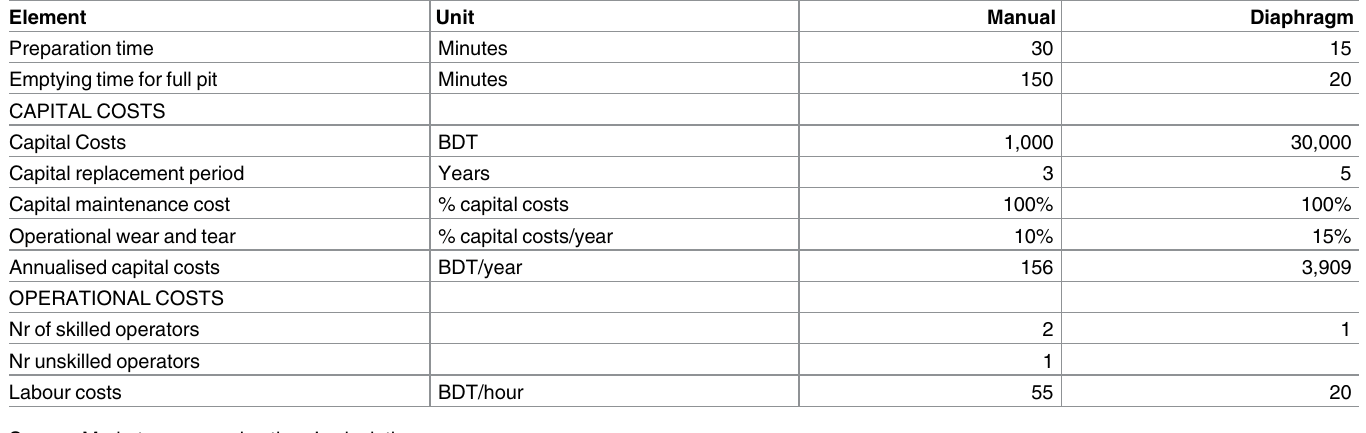
Table 4. Performancecharacteristics-emptying options.